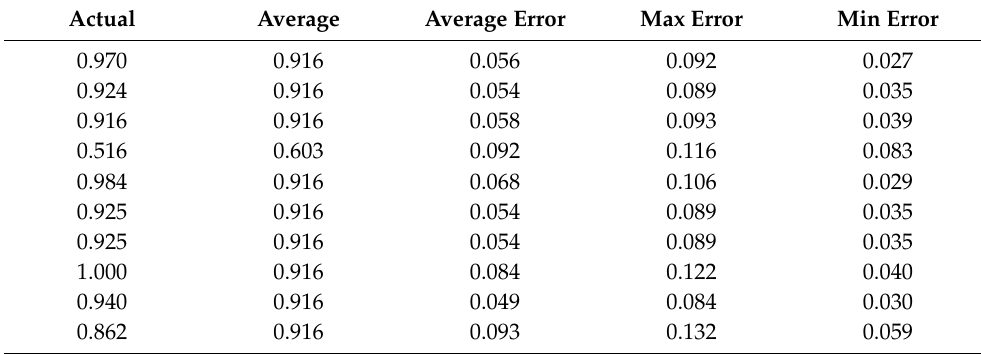
Table A173. Set 3, trials 11–20 data (actual PR value).